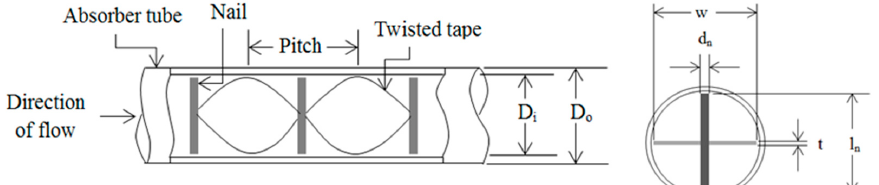
Figure 2. Schematic sectional views of NTT (nail type twisted tape).